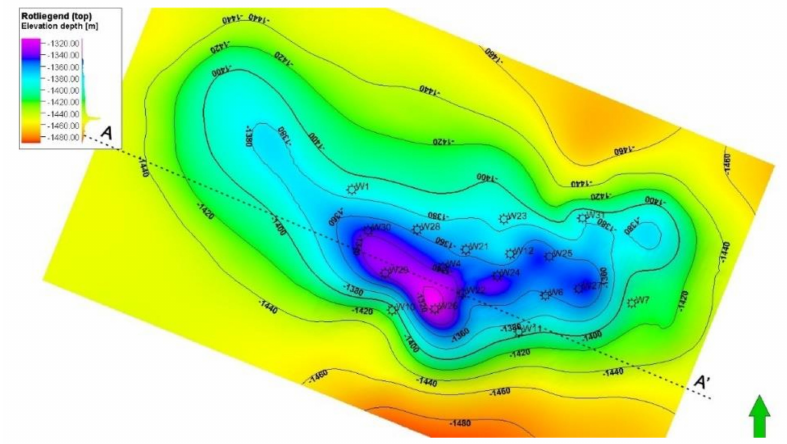
Figure 1. Structural map of the Basal limestone top. Vertical cross section line A–A’.